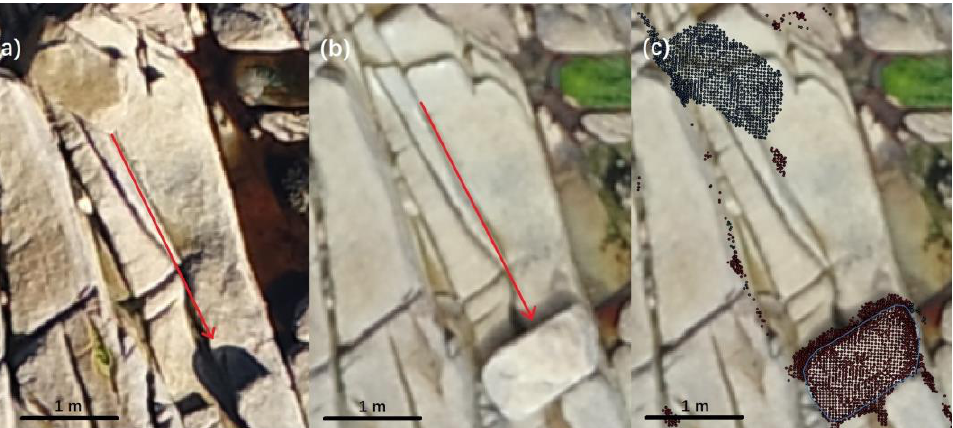
Figure 14. The movement path of a boulder. ( a ) and ( b ) indicate the location of the boulder in 2017 and 2018, respectively, while ( c ) shows the M3C2 results. The location in 2018 (red) was used to calculate the boulder volume.